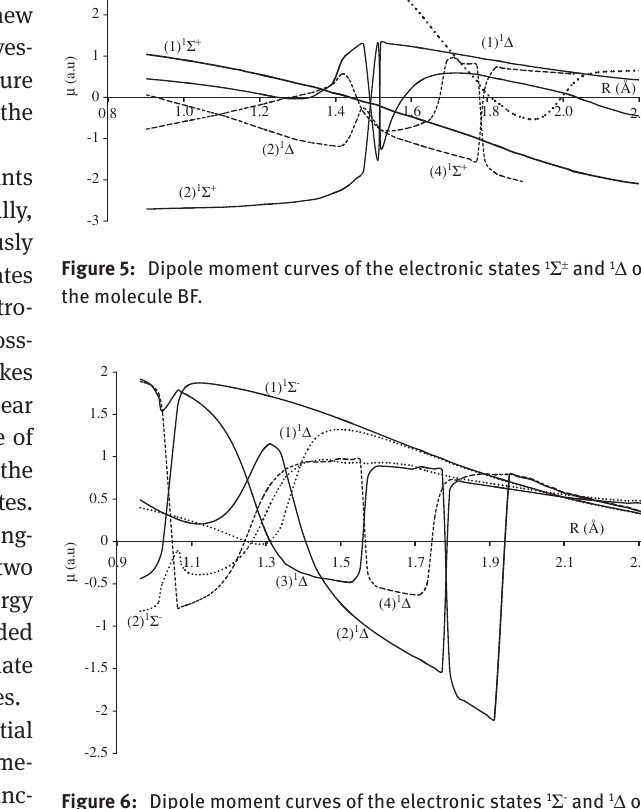
Figure 6: Dipole moment curves of the electronic states 1 Σ - and 1 Δ of the molecule